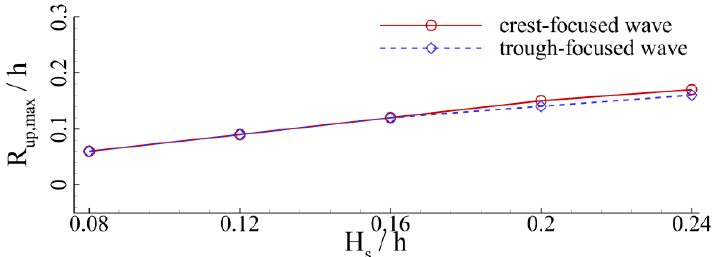
Figure 24. Maximum wave runup height versus the relative significant wave height.